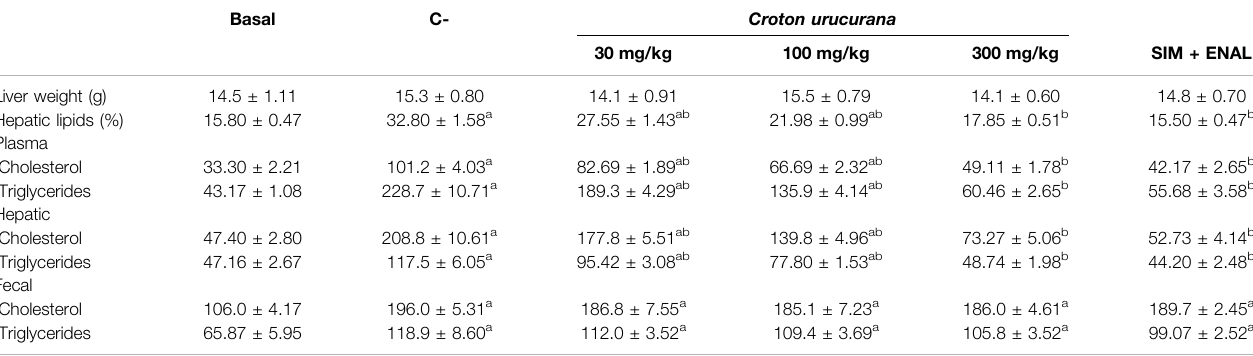
TABLE 2 | Lipid pro fi le in hypertensive, dyslipidemic, and smoker rats that were treated with vehicle, Croton urucurana extract, and simvastatin + enalapril. Basal C- Croton